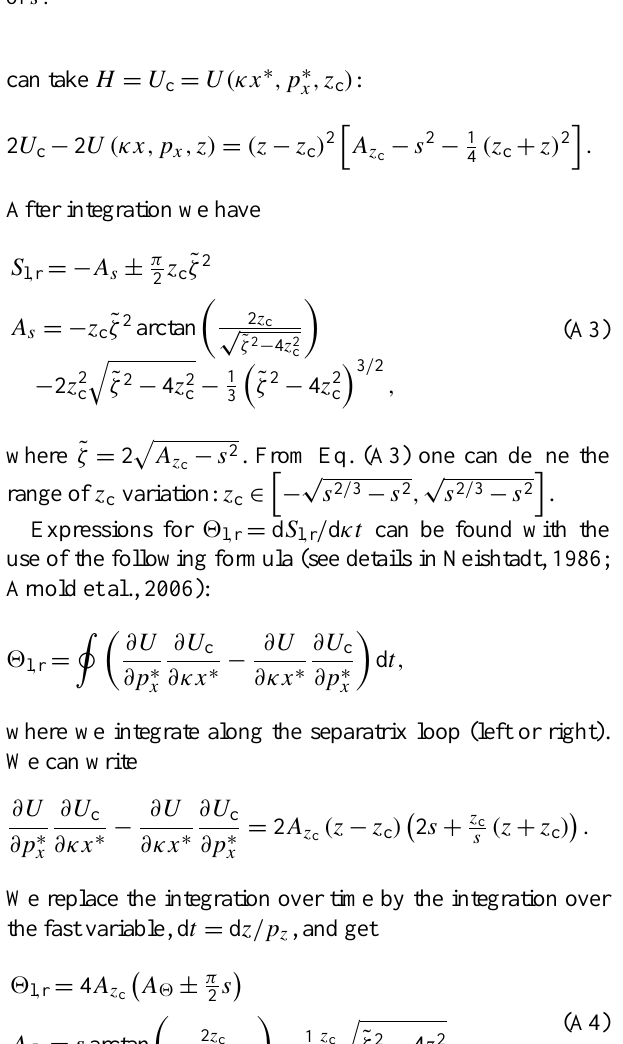
Fig. A2. The length of the uncertainty curve is shown as function of s .